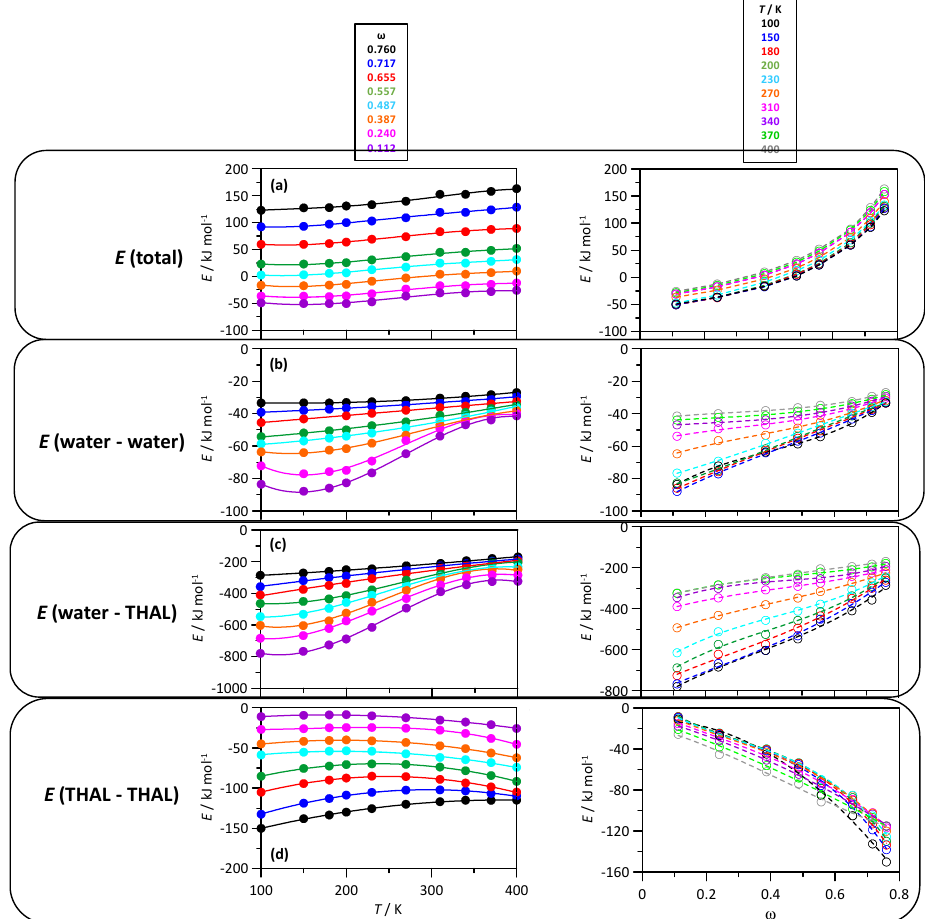
Figure 5. Evolution of relevant energy terms with mixture composition and temperature for ω THAL + (1- ω ) water mixtures. T stands for temperature and ω for THAL mass fraction. E (total) stands for the total potential energy; E (water-water), E (water-THAL) and E (THAL-THAL) for the intermolecular interaction energies (sum of Lennard–Jones and coulombic contributions) of the corresponding interacting pairs.